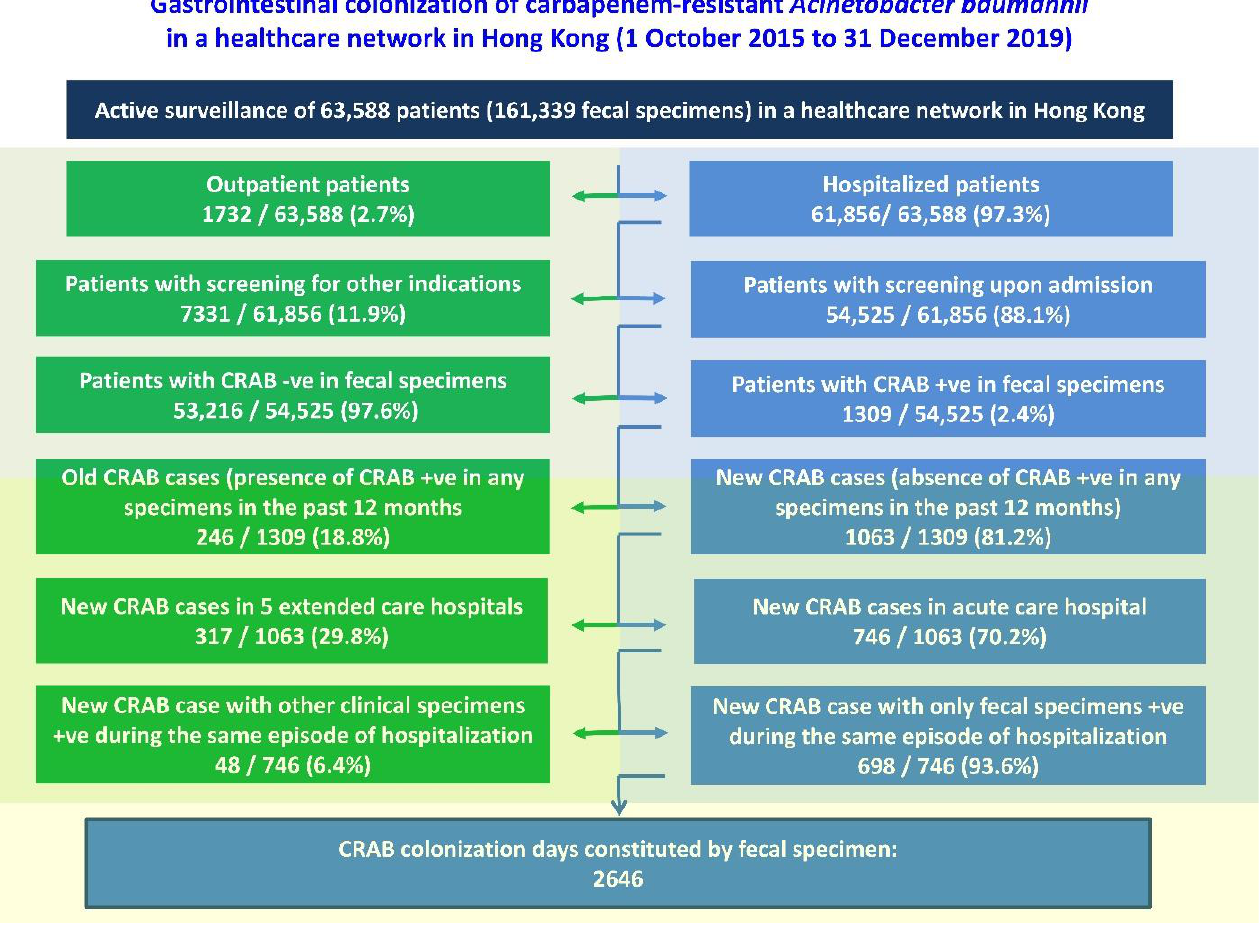
Figure 1. Gastrointestinal colonization of carbapenem-resistant A. baumannii (CRAB) in a healthcare network in Hong Kong.